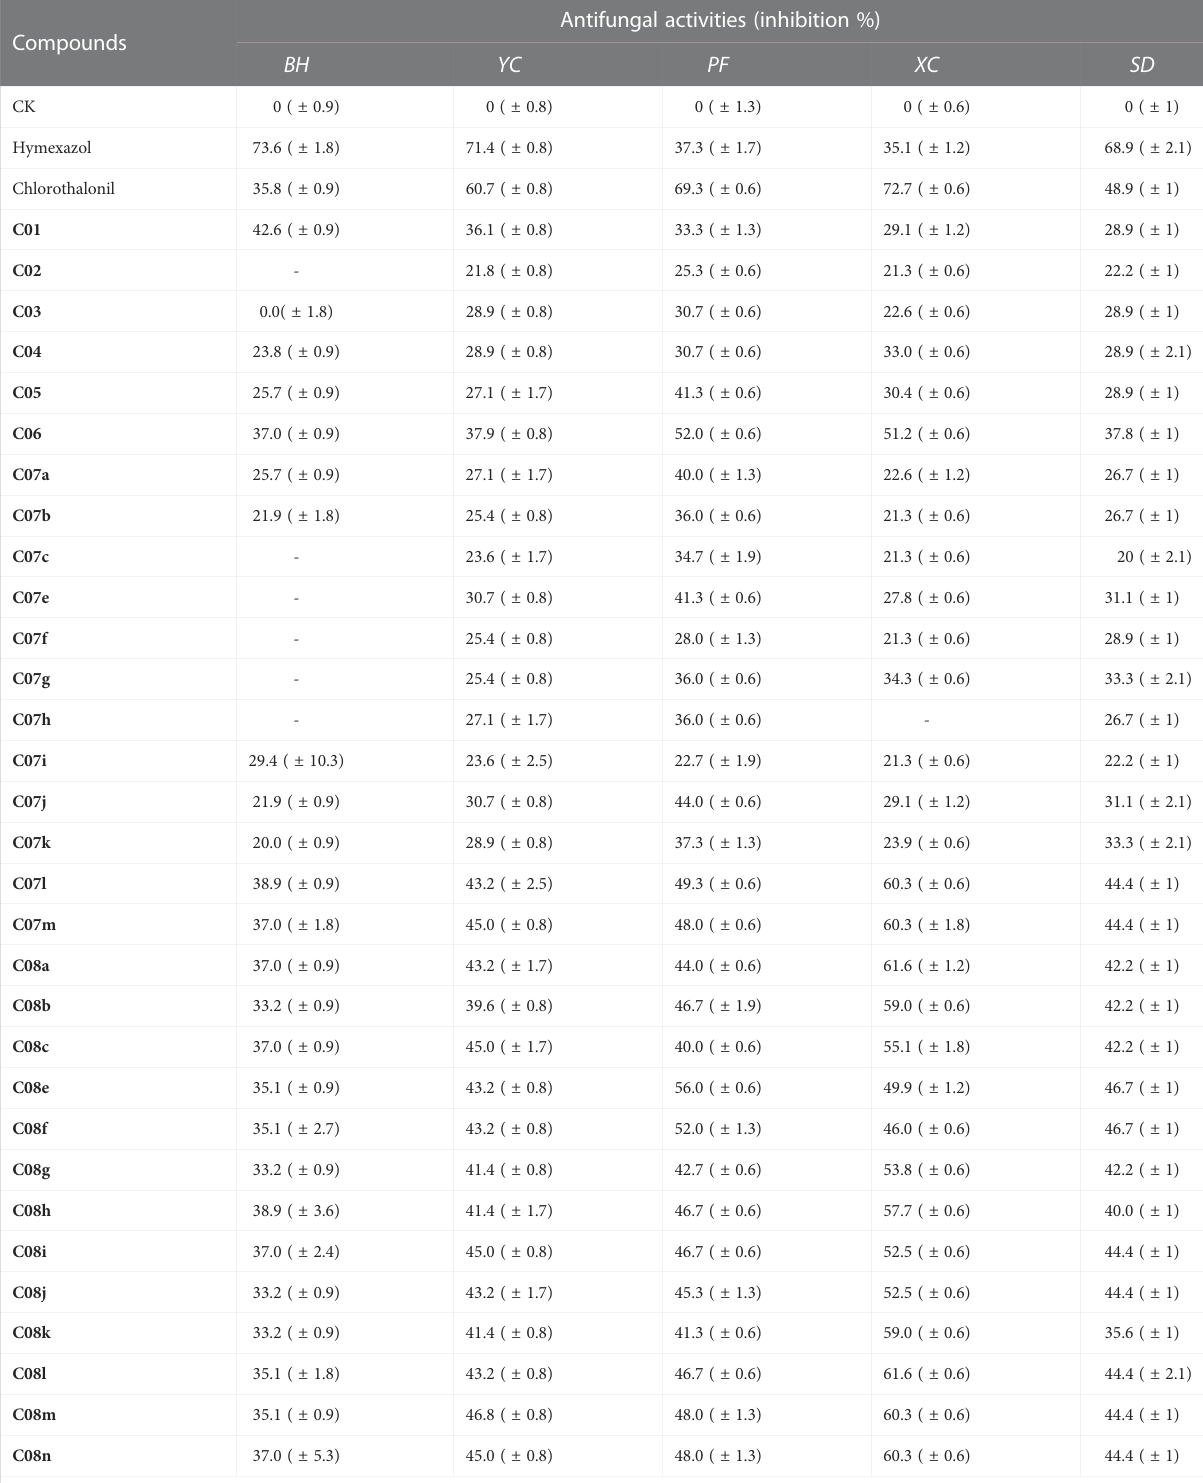
Ribociclib was used as positive control. BH: Alternaria brassicae. YC: Alternaria alternariae. PF: Valsa mali. XC: Fusarium graminearum. SD: Pyricularia